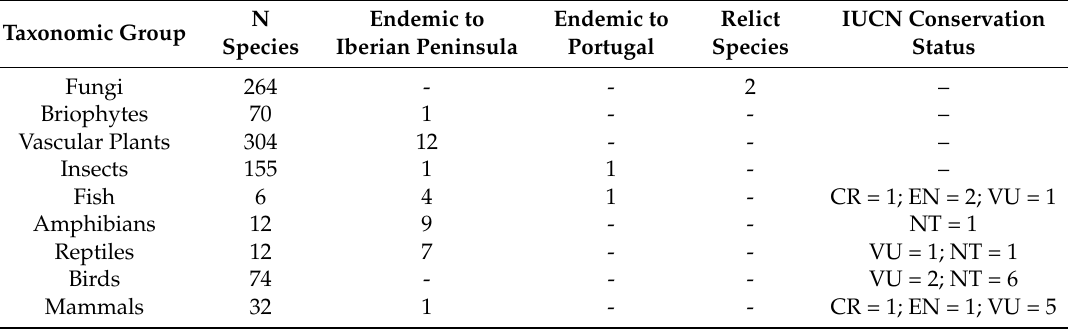
Table 1. Species richness and their International Union for Conservation of Nature (IUCN) conservation status in the study area (CR—Critically Endangered, EN—Endangered, VU—Vulnerable, NT—Near Threatened). N Endemic to Endemic to Taxonomic Group Species Iberian Peninsula Portugal